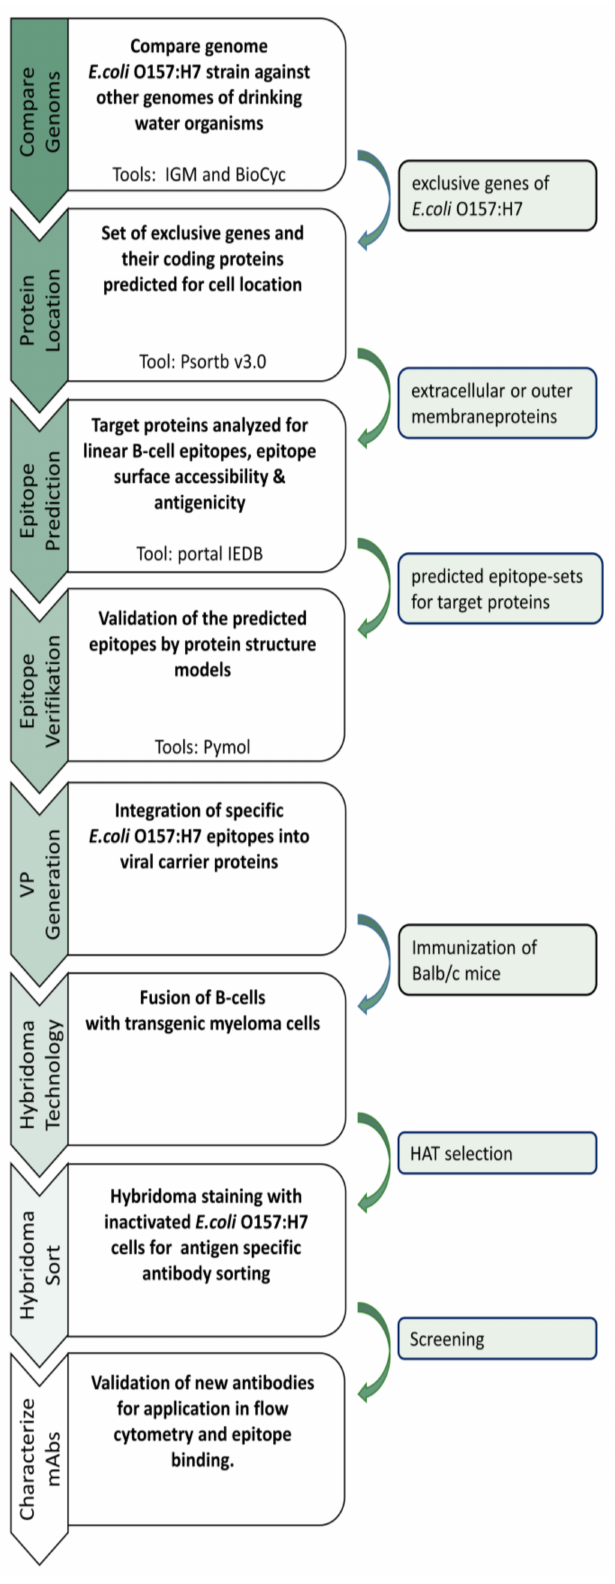
Figure 2. Schematic representation of the workflow for the generation of monoclonal antibod- ies specific for E. coli O157:H7 using bioinformatic epitope prediction in combination with novel immunization and selection